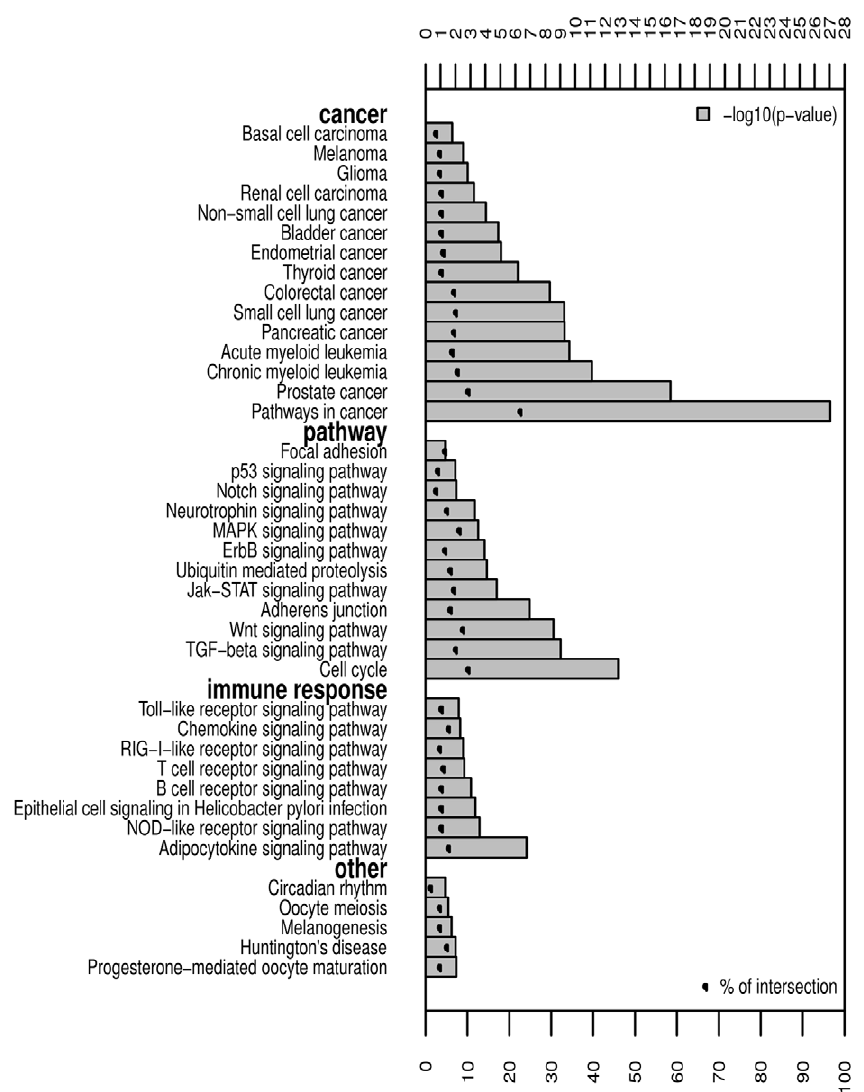
Figure 3. Signaling pathway enrichment in the MCN proteins. All proteins (nodes) in the MCN were submitted to DAVID web tool for KEGG pathway enrichment analysis. Significant pathways are shown by categories according to the 2 log10(p-value) and the percentage of intersection between the submitted list and queried annotations.